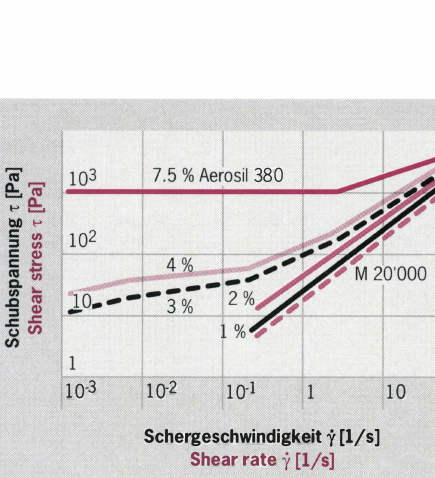
Fig. 2: Dependence of relative residual shear stress during relaxation on the shear rate of the stressing experiment.